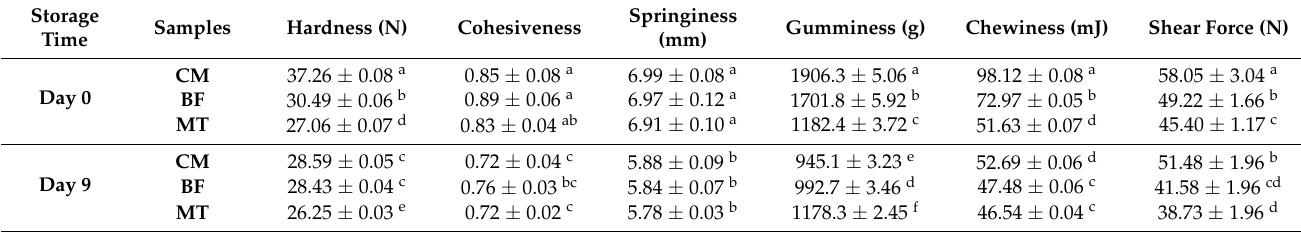
Table 2. Changes in the textural properties of camel meat (CM), beef (BF) and mutton (MT) on day 0 and day 9 of refrigerated storage.